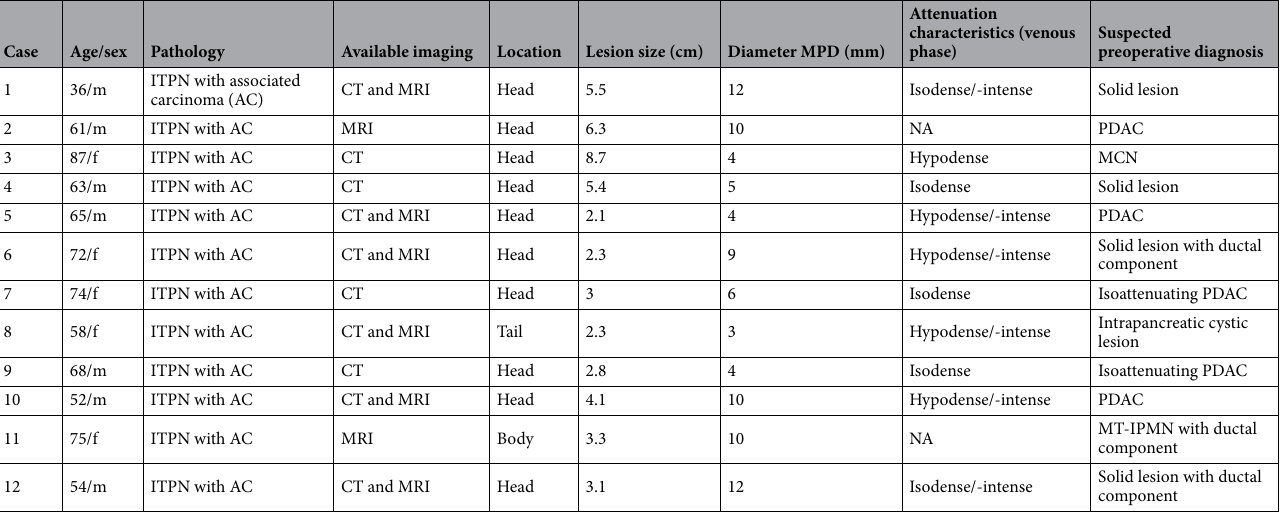
Table 1. Sex, age, imaging characteristics, and suspected preoperative diagnosis of the ITPN-patients. MPD main pancreatic duct, ITPN intraductal tubulopapillary neoplasm, CT computed tomography, MRI